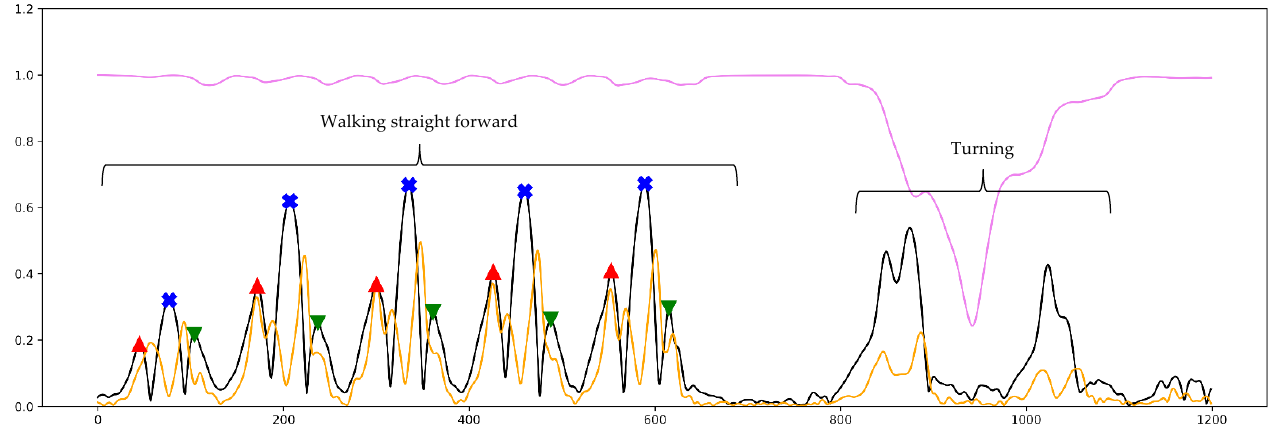
Figure 4. This figure illustrates a short part of the train dataset. Black line: smoothed AngVelMag; orange line: smoothed FreeAccMag; violet line: smoothed RotMatMag; red markers: labeled FO; blue markers: labeled MidS; green marker: labeled FC.